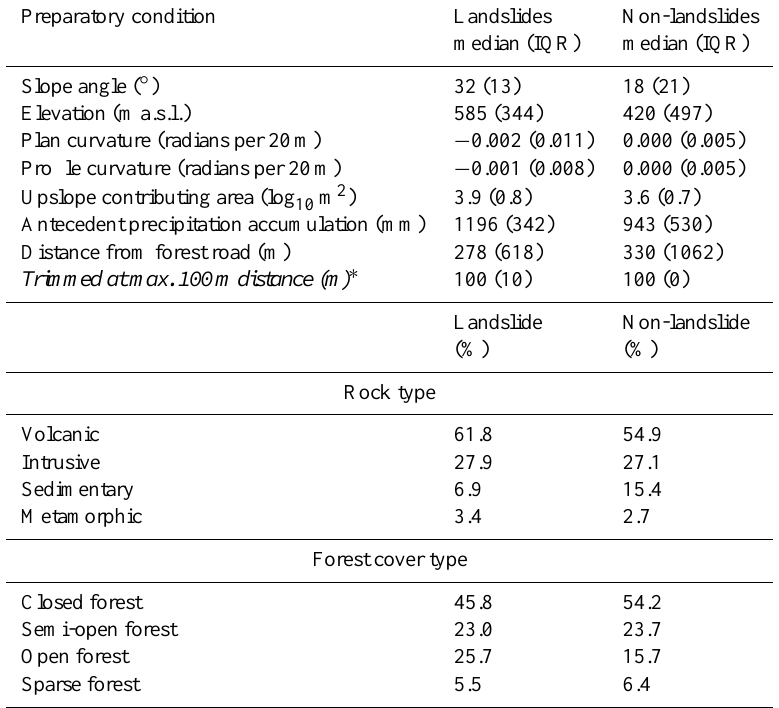
Table 4. Statistical summary of predictor variables for landslide and non-landslide observations within the study area.